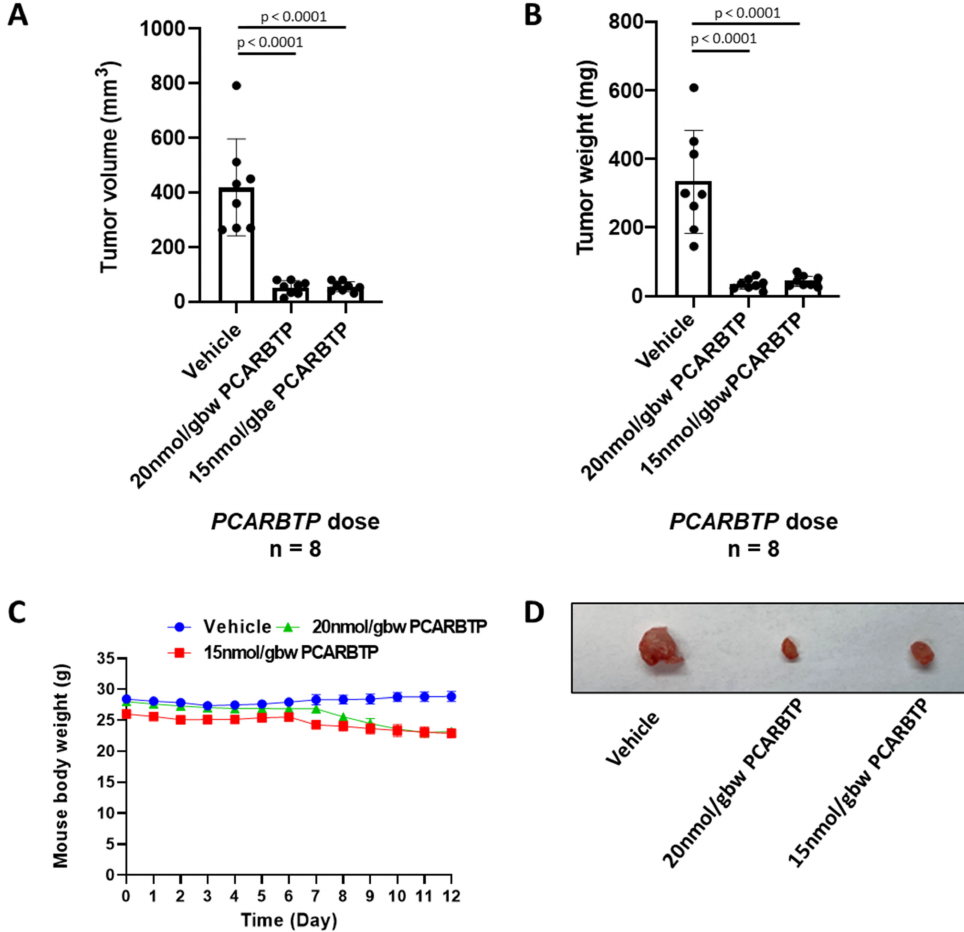
Figure 3. PCARBTP reduced pancreatic tumor size in an orthotopic mouse model. ( A , B ) PCARBTP reduced mouse pancreatic tumor volume ( A ) and weight ( B ) orthotopically significantly upon intraperi- toneal administration, n = 8. ( C ) Body weights change in the mice during PCARBTP treatment were less than 20% ( p < 0.05). ( D ) Representative pictures of the mouse orthotopically injected